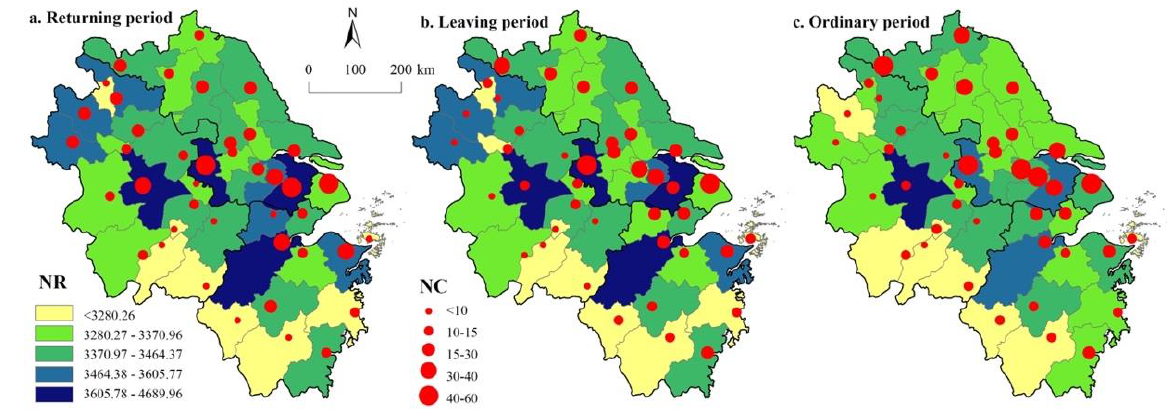
Figure 7. Spatial pattern of the impact of urban node failure on network resilience.